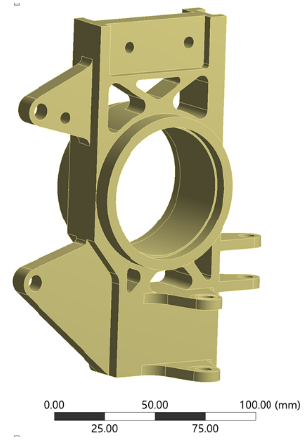
Figure 8. Geometric model after initial optimization.